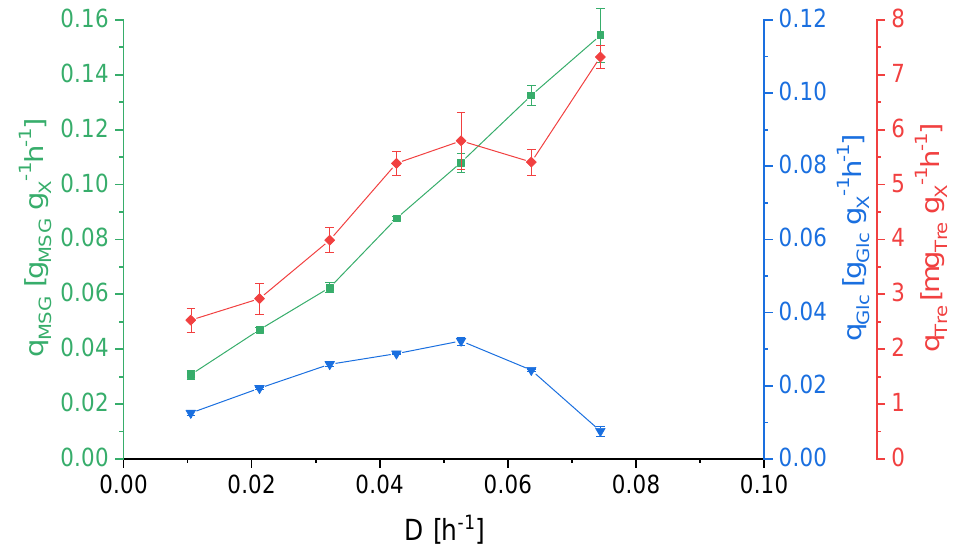
Figure 5. Specific substrate uptake rates for L-glutamate (q MSG ) and for D-glucose (q Glc ) and specific production rates of trehalose (q Tre ) in dependence of the different applied dilution rates. The specific rates at the dilution rate of 0.084 h −1 are not depicted as this dilution rate yielded highly variable rates due to it lying too close to the point of washout. Error bars indicate the difference between the various sampling points after reaching steady state in the continuous cultivation.